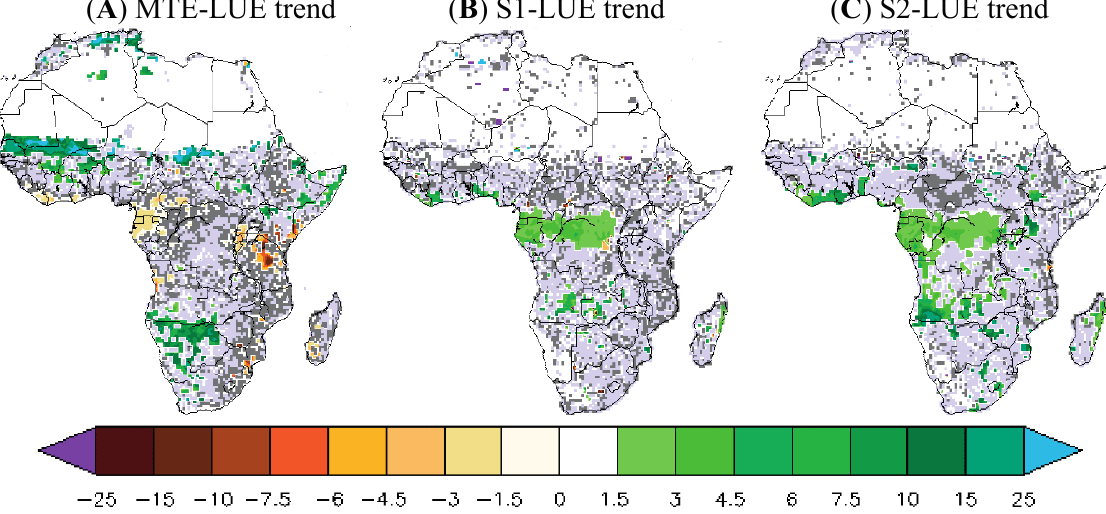
Figure 5. 1982–2010 trend of fAPAR (left column), GPP (middle column) and ET